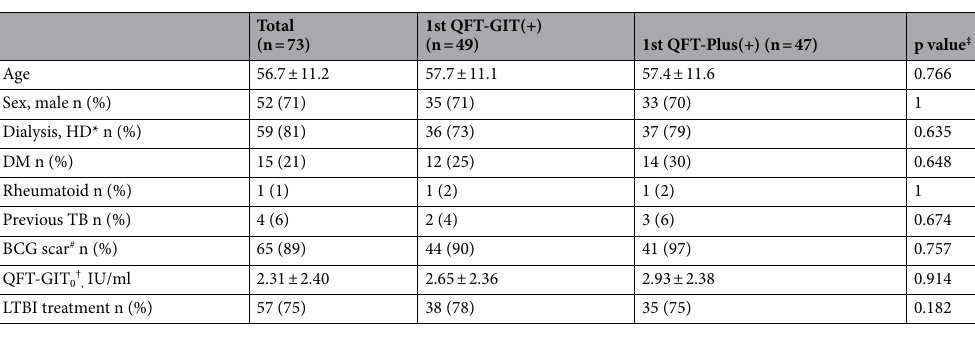
Table 1. Demographic data of study population. Data are presented as number (percentage) or mean ± standard deviation. None had underlying cancer or cirrhosis. BCG, Bacillus Calmette-Guérin vaccine; DM, diabetes mellitus; M, male; HD, hemodialysis; LTBI, latent tuberculosis infection; QFT-GIT, QuantiFERON-TB Gold In-Tube; QFT-Plus, QuantiFERON-TB Gold Plus; TB, tuberculosis. *Regarding dialysis modality, those not receiving hemodialysis received peritoneal dialysis. # Missing data of BCG: four patients in the total population; two patients in the 1st QFT-GIT(+) group and two in the 1st QFT-Plus(+) group, respectively. † QFT-GIT 0 : the interferon-gamma level of the TB Antigen tube minus the negative control tube at the baseline test of the QuantiFERON-TB Gold In-Tube. ‡ p values were compared between patients with 1st QFT-GIT(+) and those with 1st QFT-Plus(+).